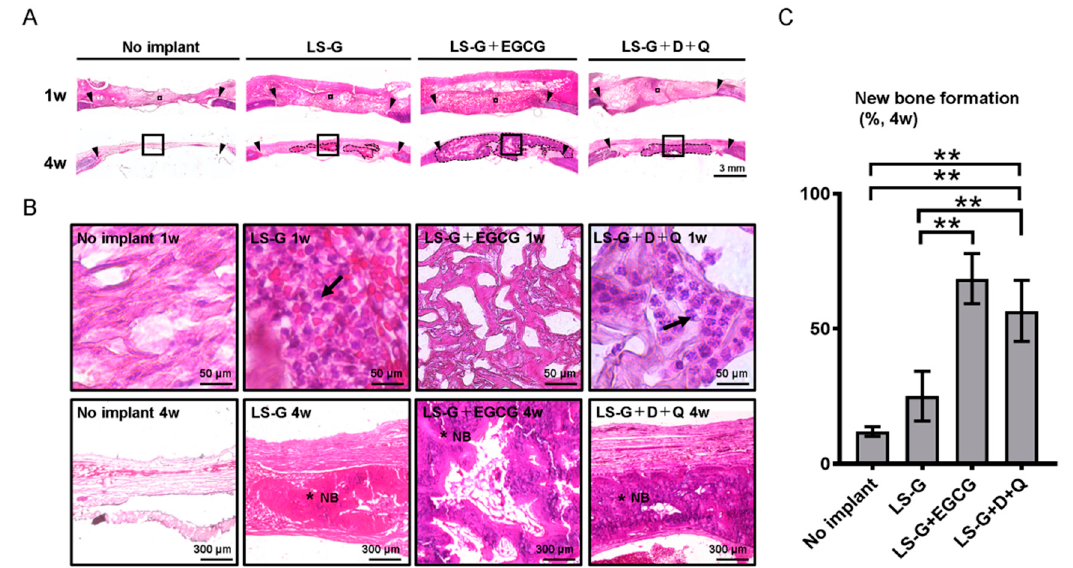
Figure 3. Histological evaluation of bone defects. Low ( A ) and high ( B ) magnification microscopic images of bone defects stained with hematoxylin–eosin one or four weeks after surgery. The image in ( B ) represents magnified squares in ( A ). Black triangles, edge of created bone defects. Black arrows, leucocytes. Black broken lines in ( A ) show newly formed bone. * NB, new bone; D, dasatinib; Q, quercetin. ( C ) Histomorphometric analysis of newly formed bones using the samples of H-E staining. Data are expressed as mean ± SD. ** p < 0.01. LS-G, implantation of LPS sustained-release gelatin sponges in bone defects; LS-G+EGCG, implantation of LS-G chemically modified with EGCG in bone defects; LS-G+D+Q, oral administration of senolytics (D+Q) with implantation of LS-G in bone defects.